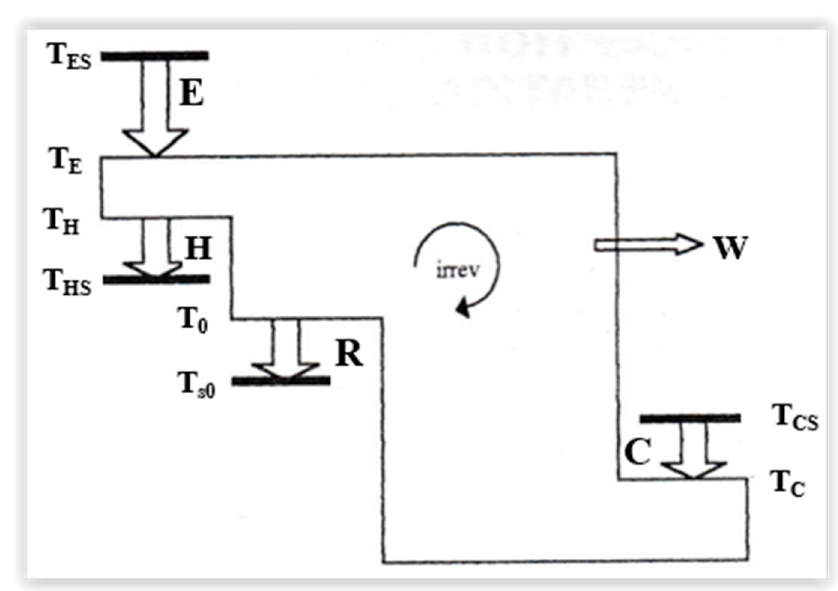
Figure 9. Scheme of a general trigeneration configuration [32].